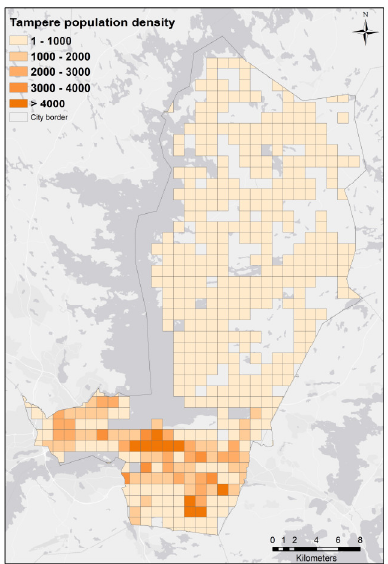
Figure 4. Population density within city of Tampere’s border. The 1 × 1 km grid cells were adopted from the Statistics Finland population dataset. Where needed, cells were clipped to fit the city extents.